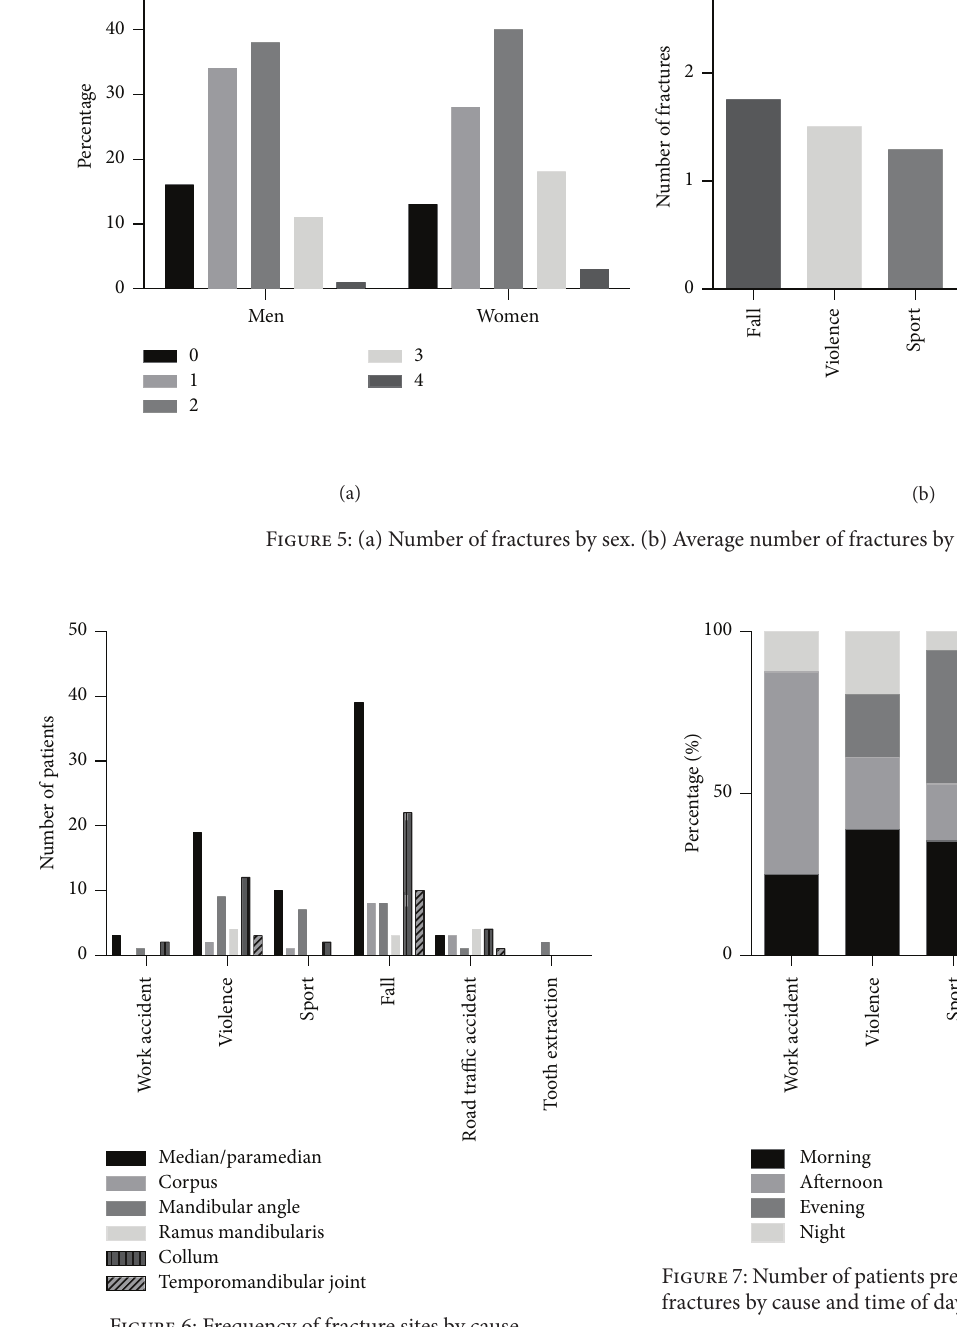
Figure 6: Frequency of fracture sites by cause.